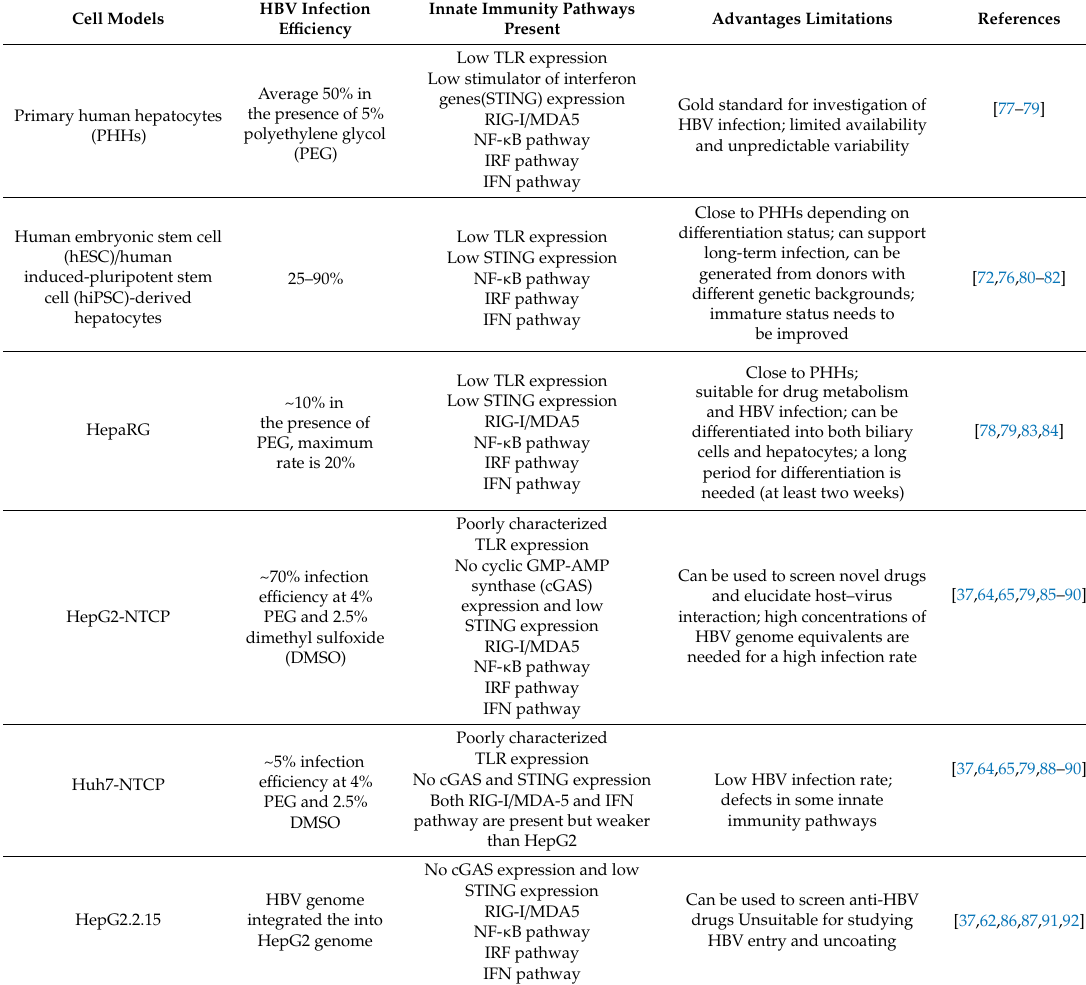
Table 2. Innate immunity pathways in HBV cell